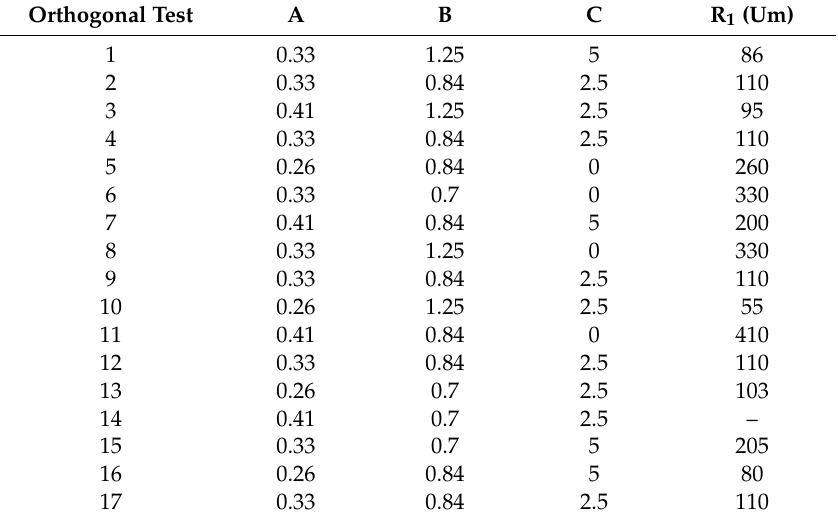
Table 2. Orthogonal test